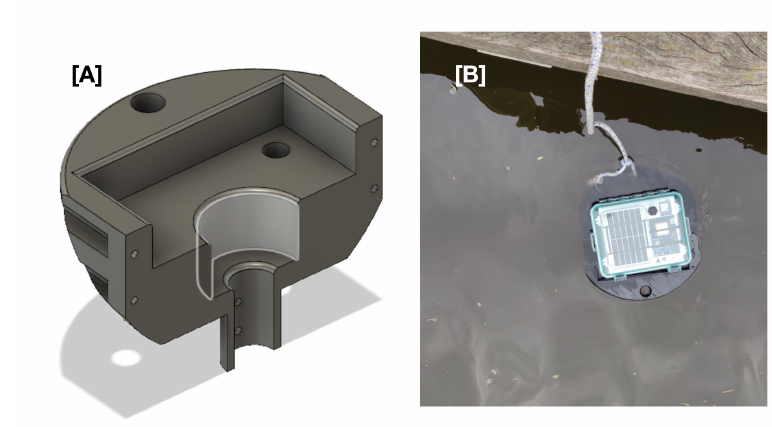
Figure 3. (A) One half of the 3D printed sleeve that was designed to protect the Maker Buoy when deployed in an ice-infested glacial lake. ( B ) A GLOF buoy with the outer protective sleeve installed undergoing buoyancy testing in a freshwater